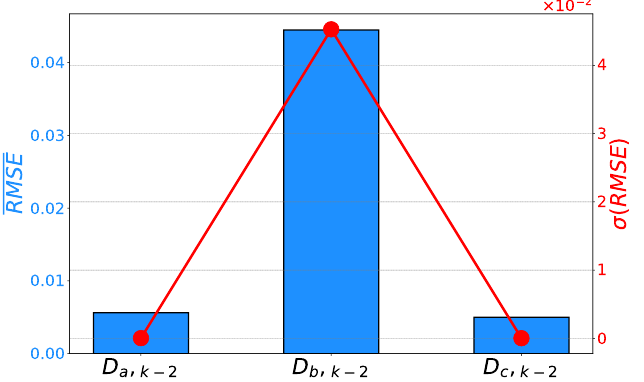
Figure 12. Mean MAE scores and their standard deviations achieved on the prediction of duty cycles.